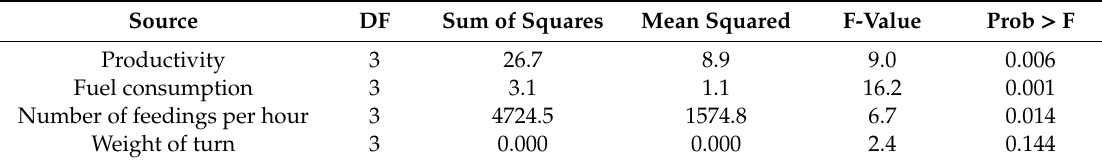
Table 2. One-way ANOVA for the productivity, fuel consumption, number of feedings per hour, and weight of turn on screen size. n = 12. Source DF Sum of Squares Mean Squared F-Value Prob > F Productivity